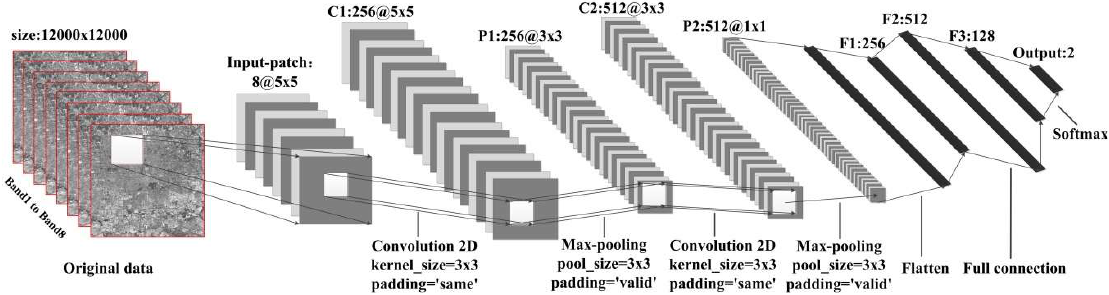
Figure 6. Network structure of CNN_2D.